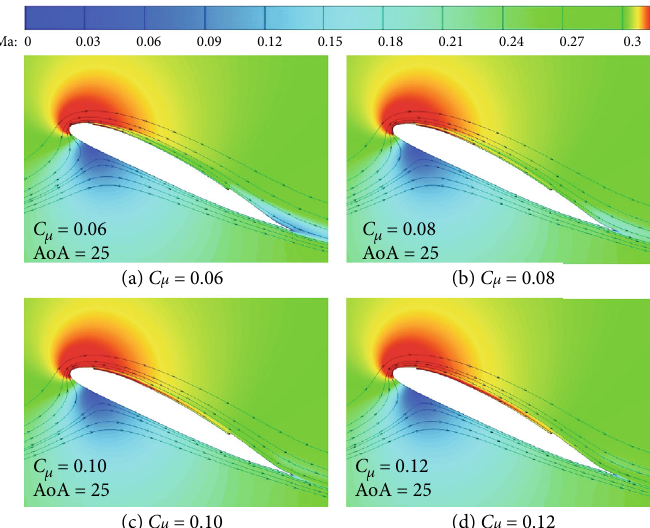
Figure 11: Mach number contours and streamlines of a OA212 CFJ airfoil with di ff erent values of C